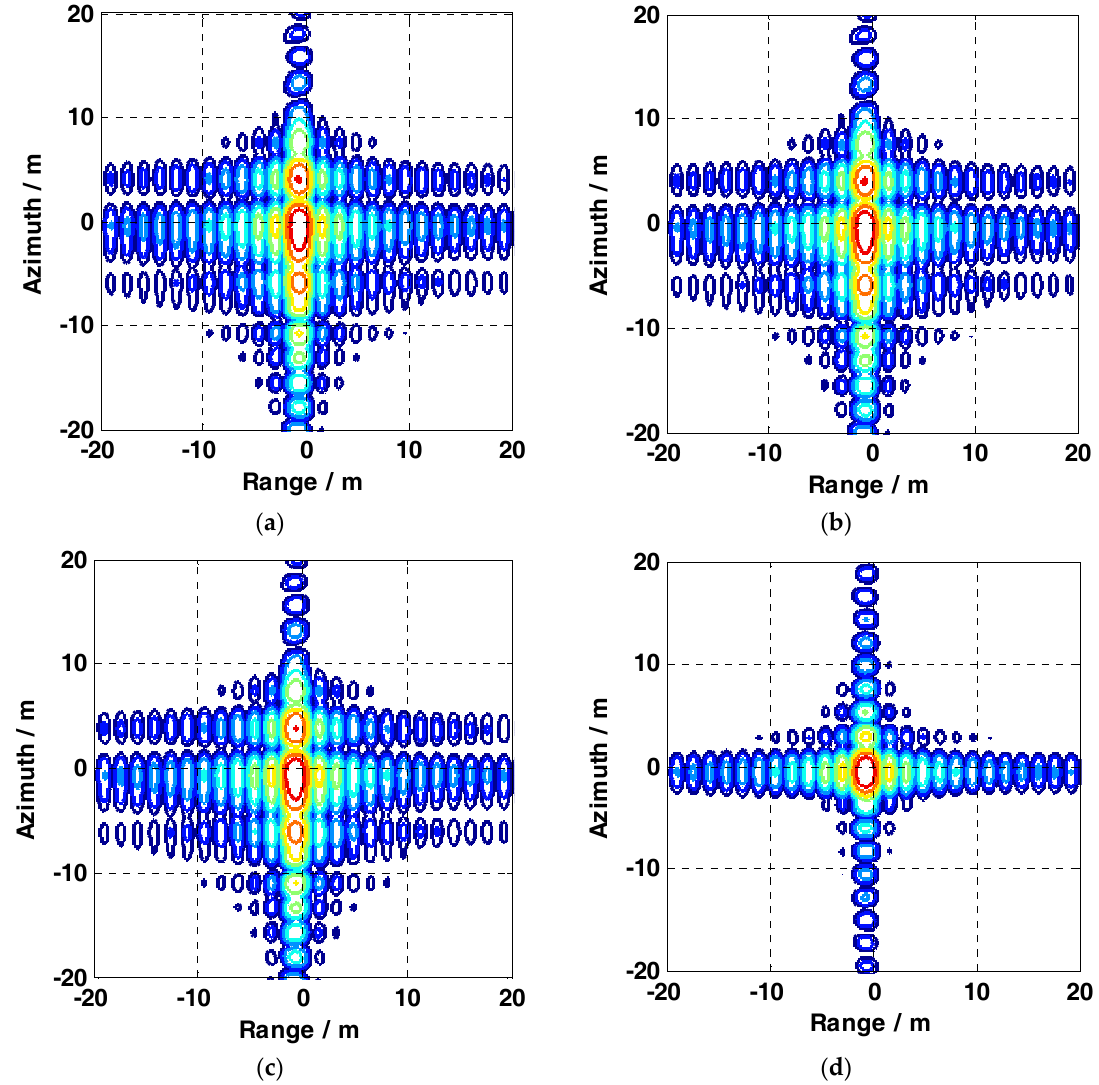
Figure 20. Target 5’s contours processed by ( a ) the conventional SAR imaging algorithm (CS algorithm), ( b ) the MD algorithm, ( c ) the PGA algorithm, and ( d ) the BLUE algorithm, for strip SAR data with linear residual motion error.